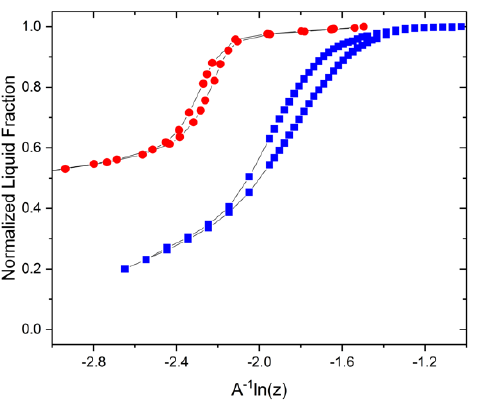
Figure 4. Comparison of nitrogen sorption isotherms (red circles) and NMR cryoporometry transi- tions (blue squares) data of MCM-41 with mean pore size ≈ 4 nm.